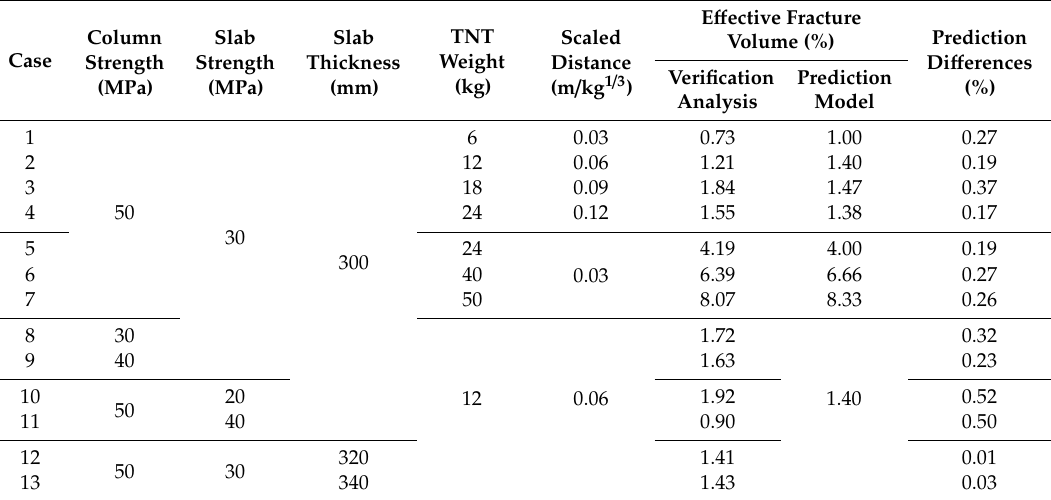
Table 5. Verification analysis variables and